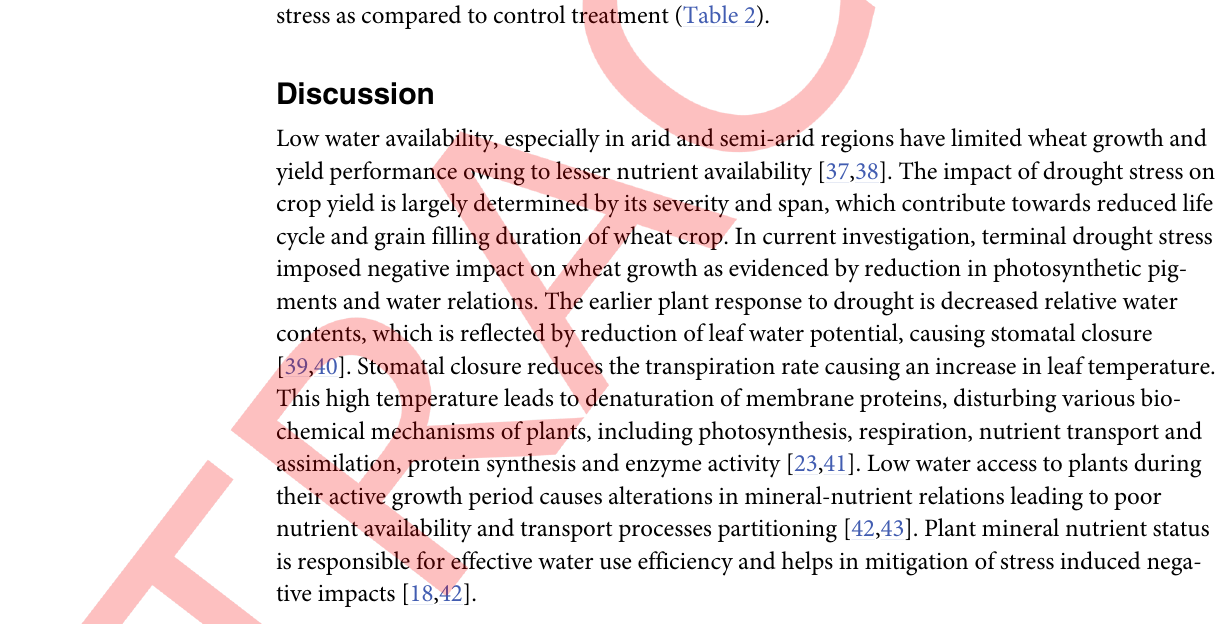
Table 2. Influence of individual and combined application of zinc and silicon on 100-grain weight, grain and biological yield of wheat under terminal drought stress.